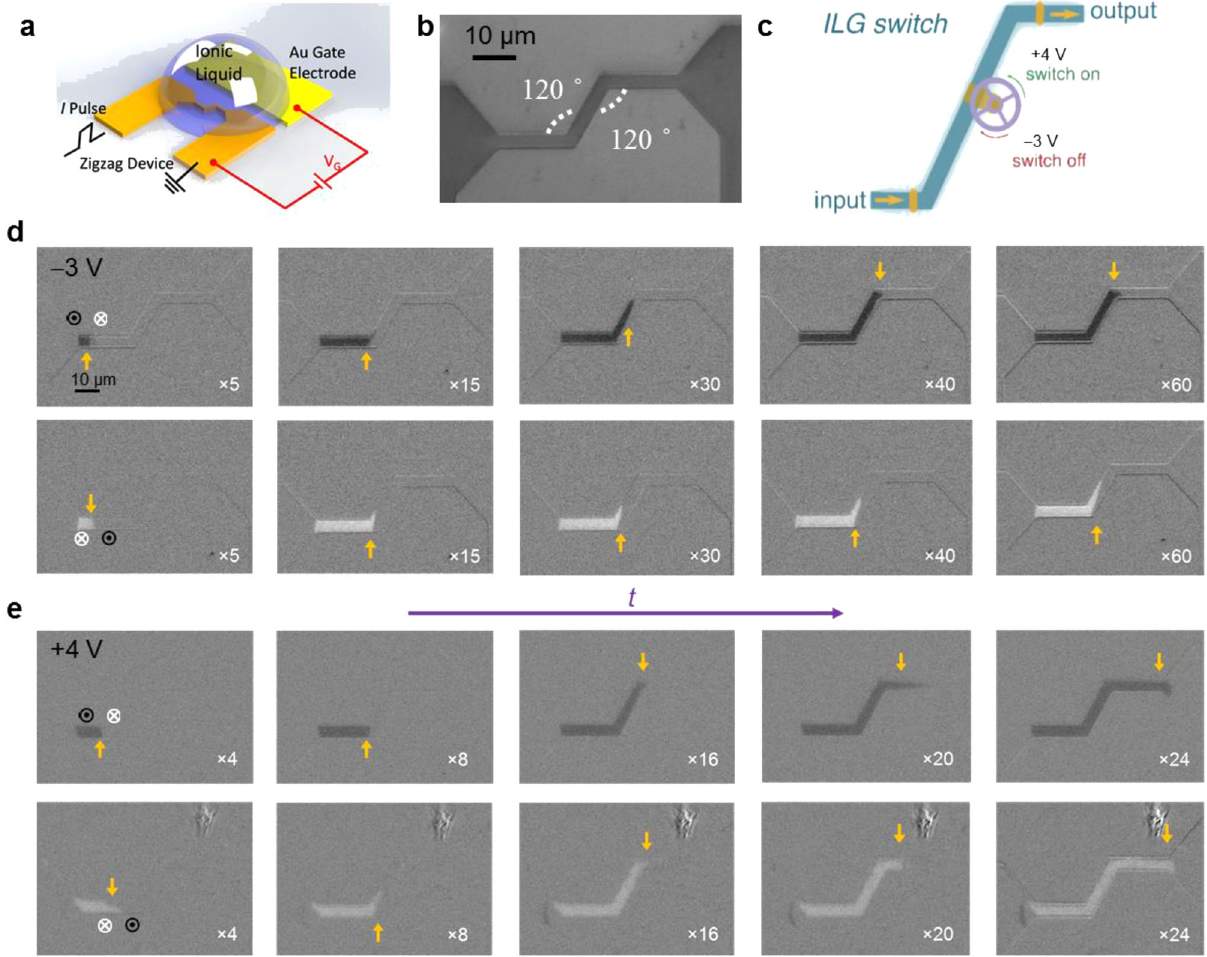
Fig. 5 ILG-controlled logic device. a Sketch of experimental setup for a “ zigzag ” device controlled by ionic liquid gating. b Optical micrograph of a typical zigzag device. c Sketch of the ILG-controlled “ switch ” function. Current-induced domain wall motion of a SAF zigzag device for V G = − 3 V ( d ) and + 4 V ( e ). Current pulses with a magnitude and length of 1.2 × 10 8 A cm − 2 and 30 ns, respectively, were used. The number of injected current pulses is given in the lower right corner of each image. The state of the initial DW is schematically illustrated in the left-most image in each row of images. The DW position is marked with yellow arrows in each Kerr Fig. 4c, when a down/up DW enters the knot device and is split into two individual DWs, the DWs exhibit highly asymmetric behavior: in the lower curved lane, the DW shows a faster velocity than in the upper curved lane, and although the DW successfully passes through the lower curved lane into the straight wire region, the DW gets stuck when exiting the upper curved lane. On the other hand, at V G = + 4 V, the incoming down/up DW splits into two DWs, showing a very symmetric behavior as the two DWs pass through both lanes at almost the same velocity and exit both curved lanes freely (Fig. 4d). For an up/down DW, as shown in Supplementary Fig. 6, at V G = – 3 V, the DWs also show an asymmetric characteristic but in an inverted manner; at V G = + 4 V, the DW behaves exactly as the down/up case with a symmetric behavior in both lanes.